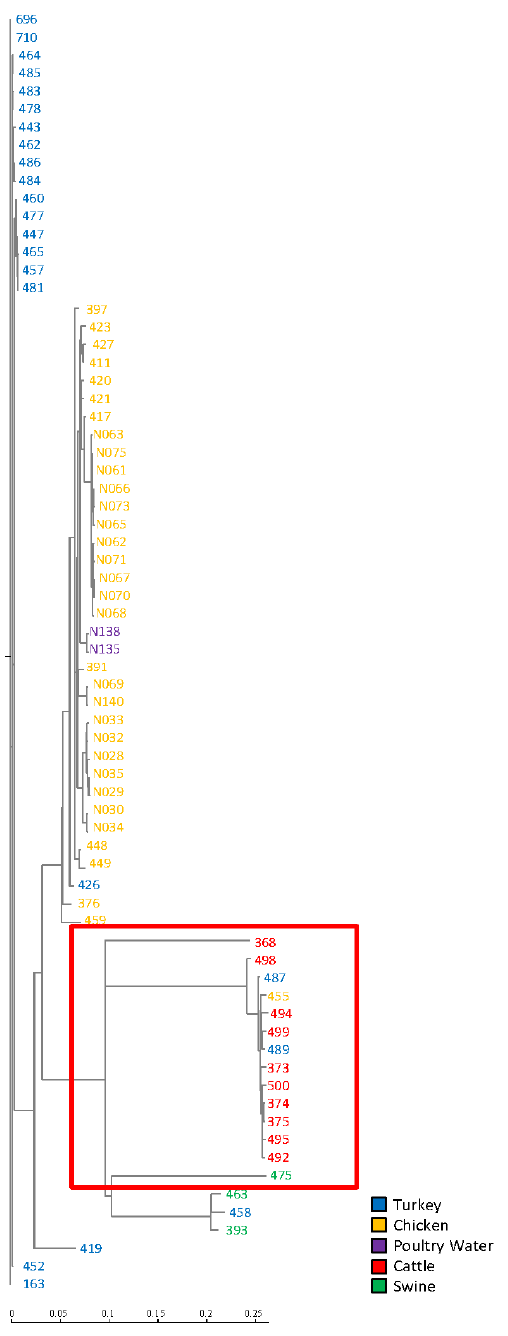
Figure 2. Phylogenetic analysis for 71 S. Typhimurium. SNP analysis indicates most of the isolates clustered together based on the host origin and some iosolates grouped together based on geographic region. The red box indicates spv genes were found in these isolates. The numbers on the scale present the percentage of genetic variation.